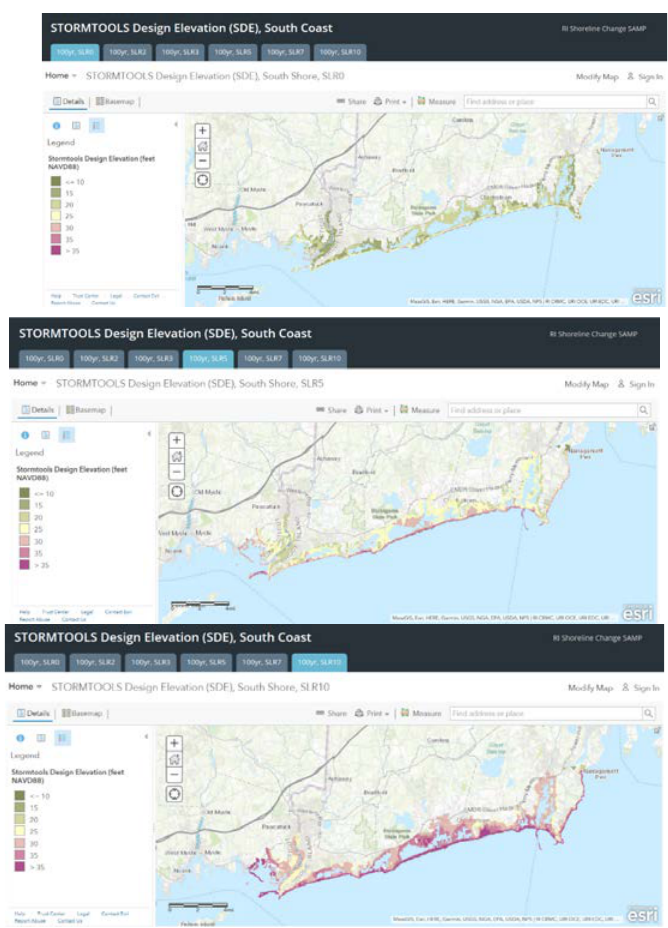
Figure 6. Impact of SLR on Narragansett Bay SDE maps, cases shown are 0, 5 ft, and 10 ft (0, 1.5, and 3 m) (upper, middle, and lower panels, respectively, note highlighted tab) SLR. (Note that the background map in these figures used the topographic map shown earlier. Background maps were user selected.). To help gain insight into the maps, Figure 7 shows the surge inundation levels (upper panel) and associated wave heights (lower panel) for the no-SLR case. The sum of the two is the BFE shown in Figure 5.